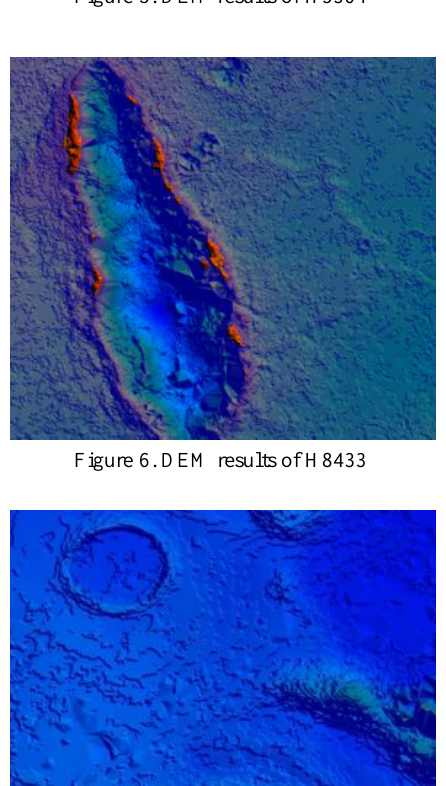
Figure 5. DEM results of H3304